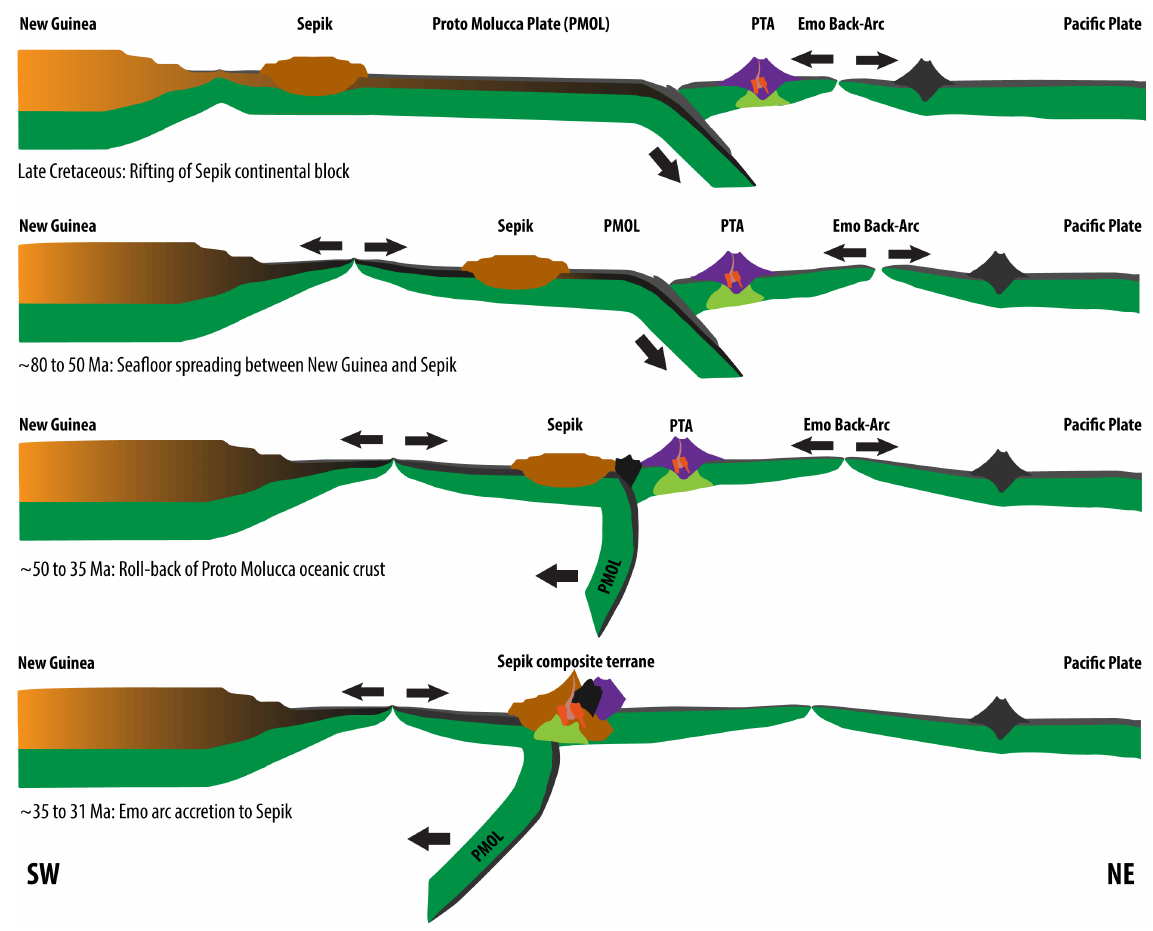
Fig. 14. Schematic cross section of Sepik tectonic evolution depicting a Late Cretaceous rifting scenario of the Sepik continental fragment and eventual collision and accretion of the Emo volcanics that formed in a back-arc setting, likely on the periphery of the Pacific Plate resulting from rollback of the proto-Molucca slab (PMOL). The PMOL slab may have been overridden by the leading edge of New Guinea due to the northward motion of the Australian continent, and the buoyancy of the young Sepik oceanic lithosphere. However, numerical models of subduction will be useful to test the vertical sinking and lateral advection of slab material from this subduction zone. The Emo volcanic arc accretes to Sepik, leading to continued north-dipping subduction of Cretaceous-age seafloor, terminating at 27Ma when the Sepik composite terrane is accreted onto northern New Guinea. PTA–proto-Torricelli Arc. Cross section largely follows the profile (dashed green) in Fig. 11. Not to